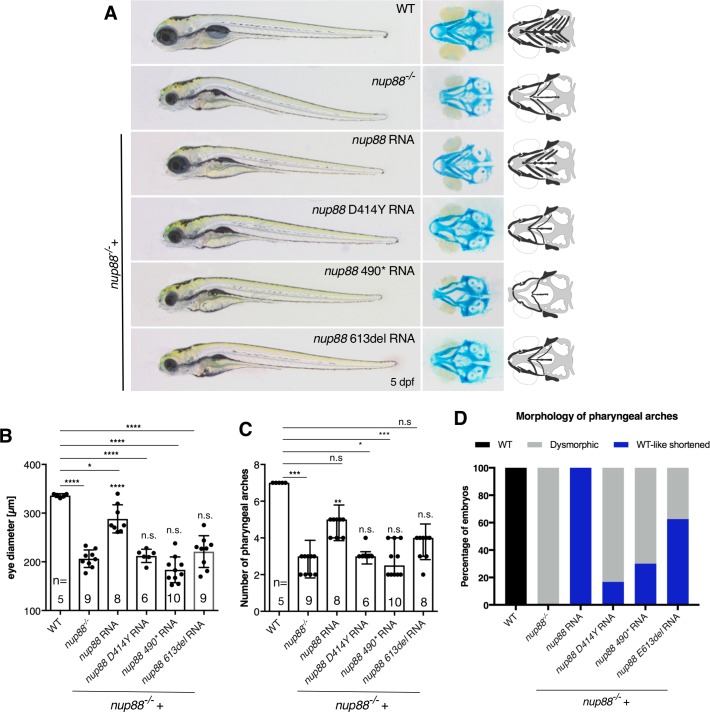
Wild-type nup88, but not disease-related mutant forms, rescue defects of nup88-/- embryos.(A) nup88+/- embryos were in-crossed and 300 pg of mRNA encoding wild-type or the respective mutant nup88 were microinjected at the one-cell stage. The extent of rescue of each variant mRNA was evaluated after 5 dpf using (B) the diameter of the eye (One-way ANOVA test), (C) the number of pharyngeal arches (Kruskal-Wallis test) and (D) their morphology as readouts. Only injecting wild-type, but not the mutant forms of nup88 mRNA, rescued the reduced eye size and the number of pharyngeal arches as revealed by Alcian blue staining (A). At least three independent injections were performed for each condition. Values are mean ± SD. Significance in comparison to nup88+/+ and nup88-/- embryos, respectively. n.s., non- significant, *P<0.05, **P<0.01, ***P<0.001, ****P<0.0001. The statistical annotations appearing just above the histogram bars refer to the comparison to the uninjected mutants. n is number of embryos/larvae analyzed. In (D) 21 larvae from 3 independent experiments (3x7) were analyzed for each form.